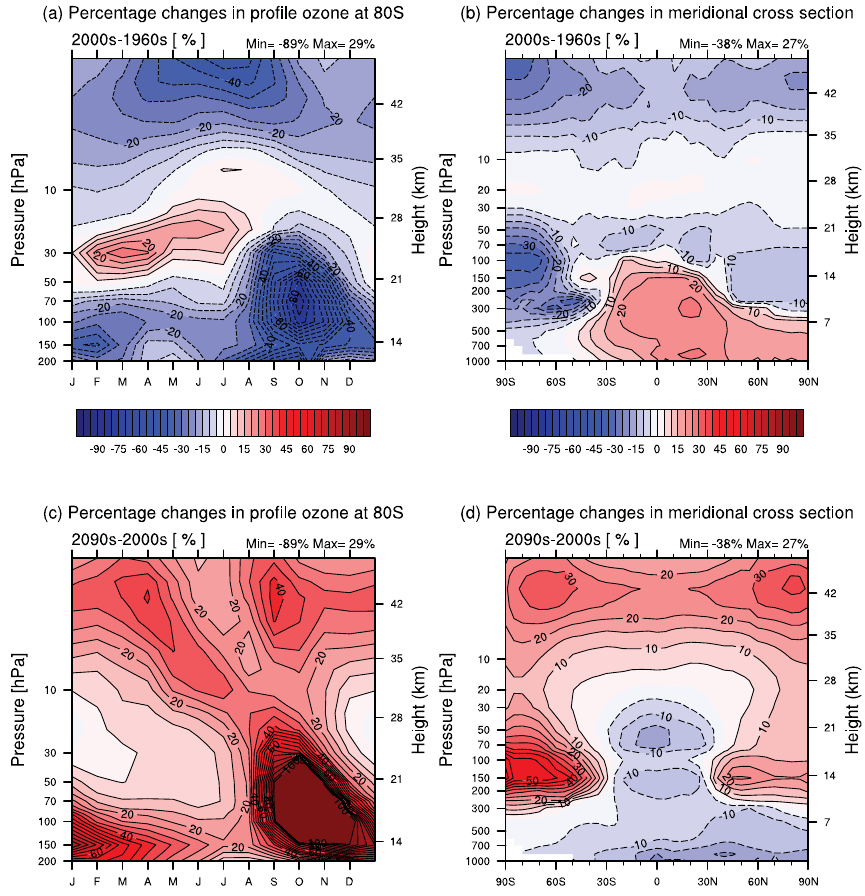
Fig. 13. (a) Annual cycle at 80 ◦ S and (b) meridional cross-section of the percentage differences in ozone between the 1960s and the 2000s. (c, d) Same as (a, b) , but for the differences between the 2000s and the 2090s. The future GHG scenario shown is RCP 4.5 in the troposphere and SRES A1B in the